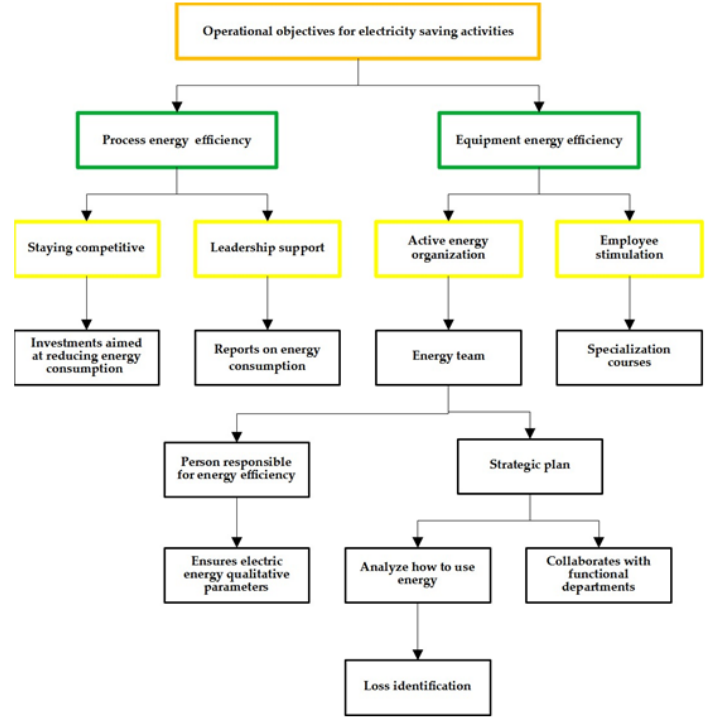
Figure 1. Operational objectives for energy-saving activities. Operational objectives related to the energy efficiency of products will be the objective of another case